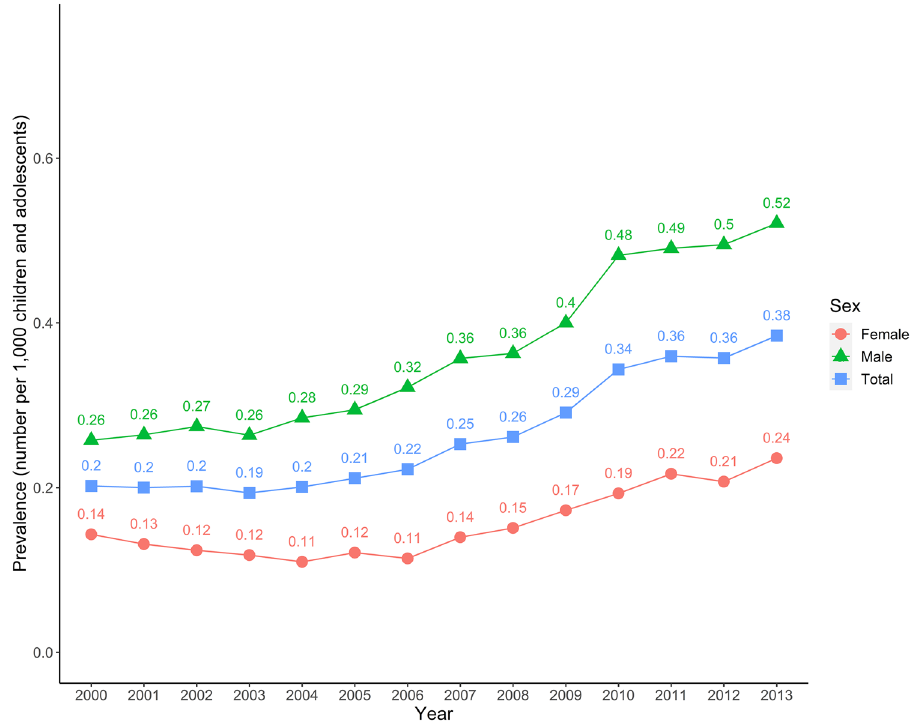
Figure 1. The annual prevalence of hypertension among children and adolescents and its trends from 2000 to 2013. The figure was generated by R Statistical Software, vers. 3.6.1. (R Foundation for Statistical Computing, Vienna, Austria; http://www.r-proje